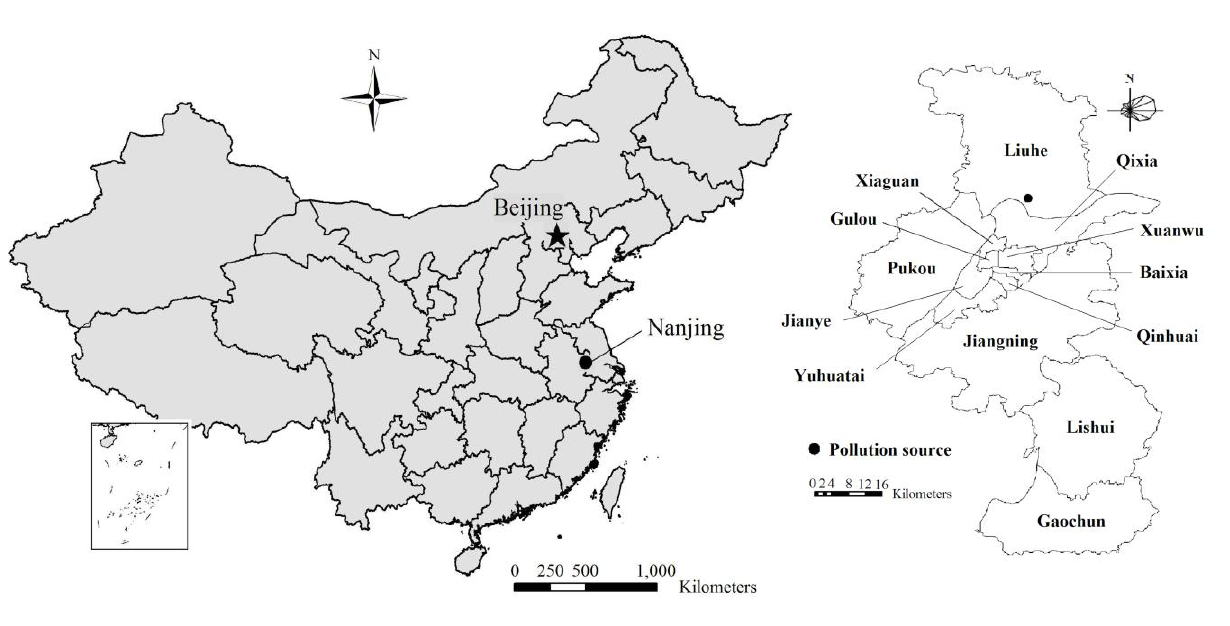
Figure 1. The location and administrative districts of Nanjing in